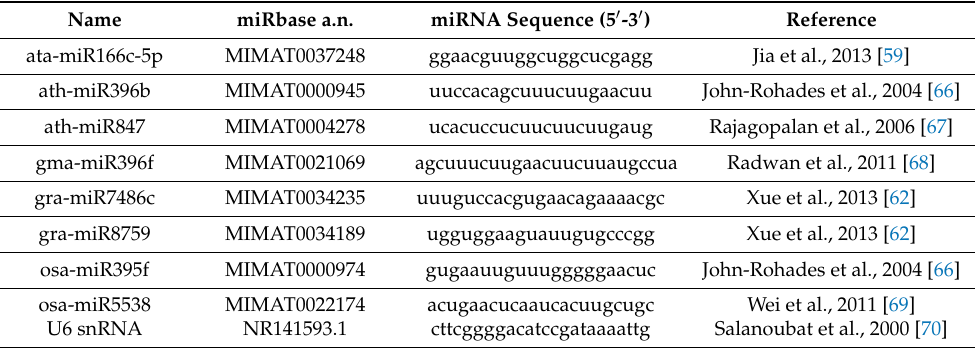
Table 3. Sequences of mature miRNAs selected for the expression analysis in Echinochloa crus-galli